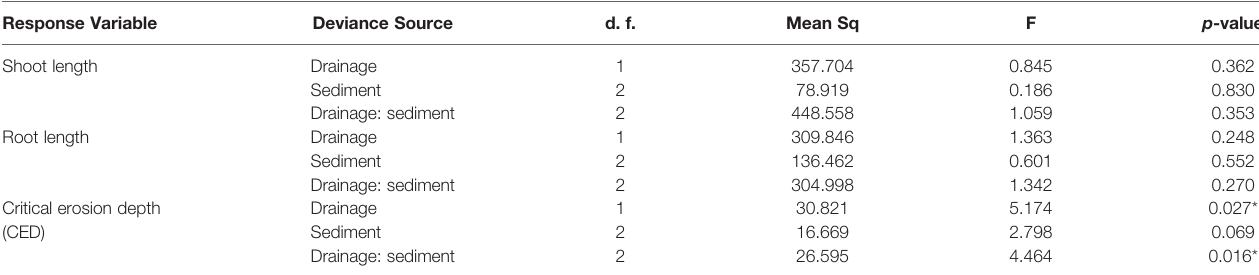
TABLE 4 | Two-way ANOVAs table show effects of drainage, sediment, and their interactions on S. anglica seedling growth traits in the mesocosm